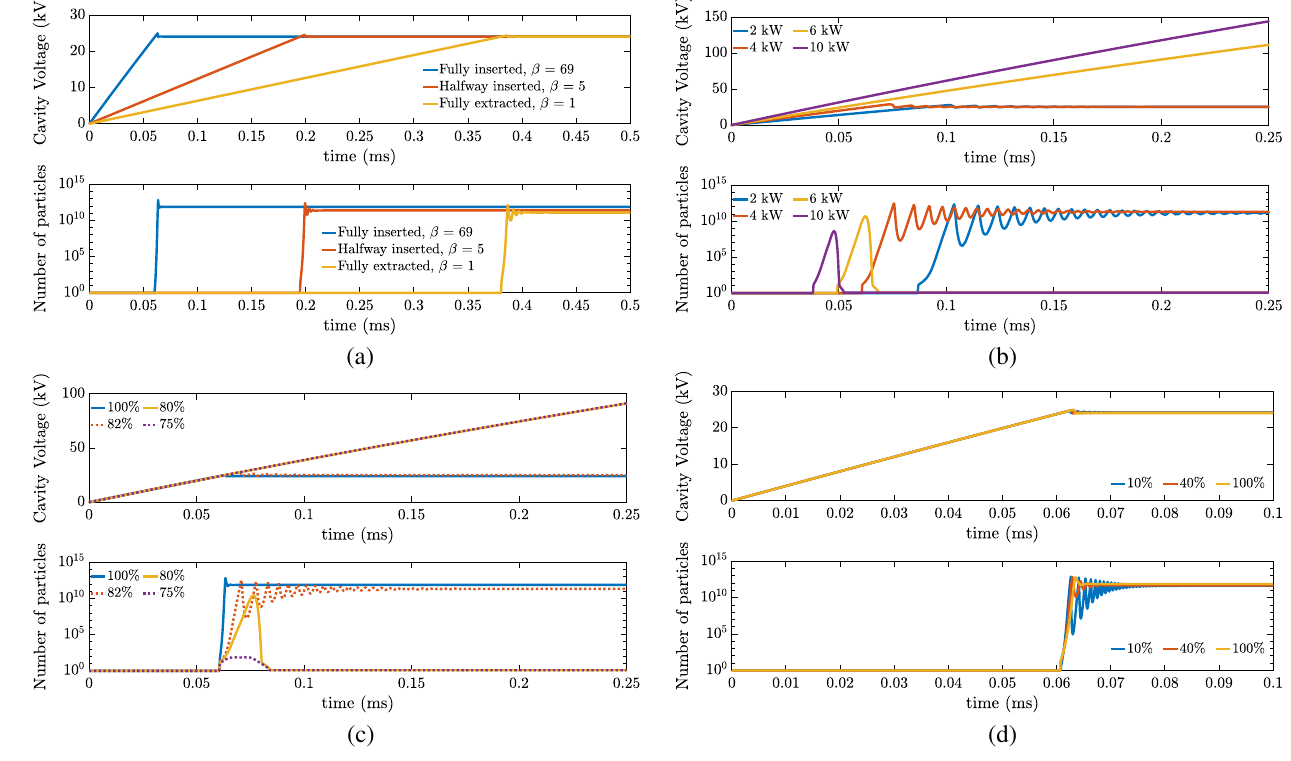
FIG. 21. Cavity voltage and the number of secondary electrons as a function of time with the presence of the 2nd order MP: (a) SEY for Nb, 4 kW input power and various positions of the FPC; (b) fully inserted FPC, SEY for Nb and various values of the input power; (c) fully inserted FPC, 4 kW input power and different uniform scaling of the SEY for Nb; (d) fully inserted FPC, 4 kW input power, SEY for Nb for various widths of the MP